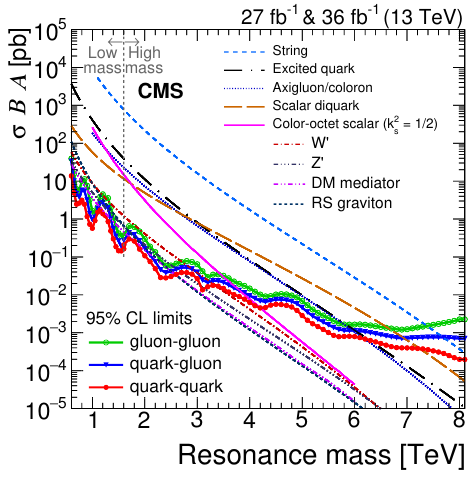
Figure 12 . The observed 95% CL upper limits on the product of the cross section, branching fraction, and acceptance for quark-quark, quark-gluon, and gluon-gluon dijet resonances. Limits are compared to predicted cross sections for string resonances [23, 24], excited quarks [26, 27], axigluons [28], colorons [29], scalar diquarks [25], color-octet scalars [30], new gauge bosons W 0 and Z 0 with SM-like couplings [32], dark matter mediators for m DM = 1 GeV [34, 35], and RS gravitons